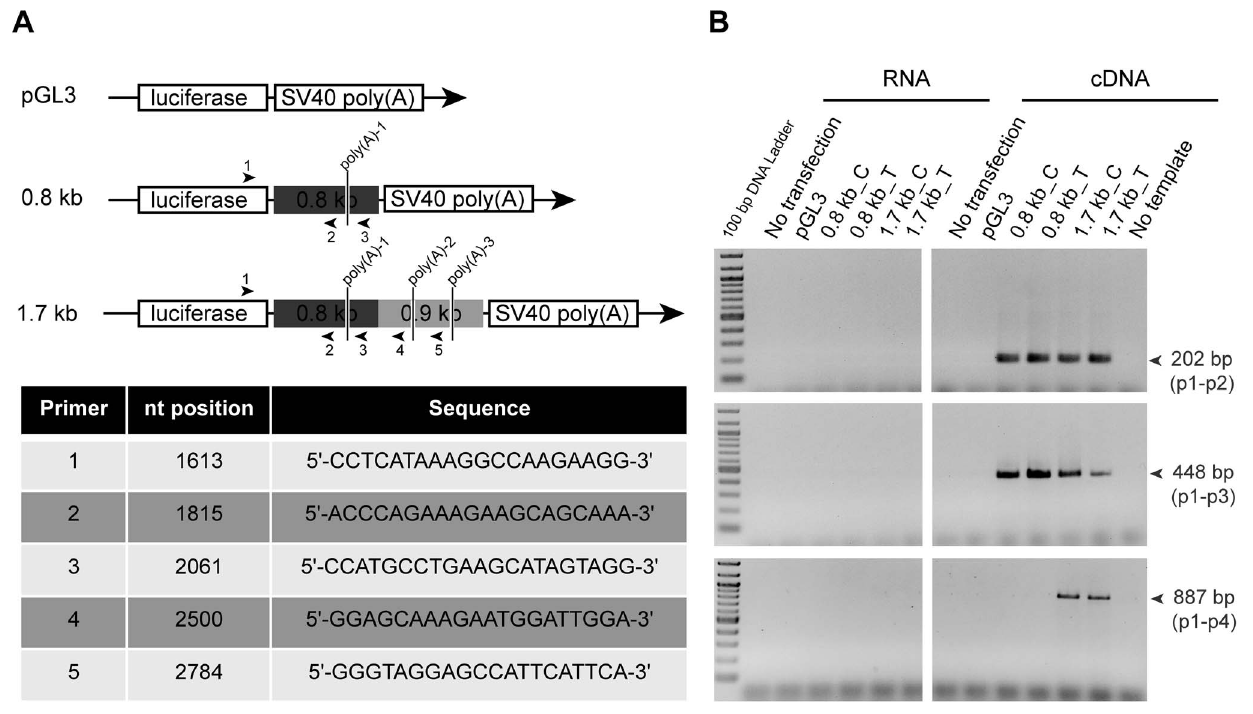
Figure 3. The length of transcripts generated is construct-dependent. (A) Schematic representation of the empty pGL3 vector and 0.8 kb and 1.7 kb constructs. Predicted poly(A) signals are indicated in each construct in between primers used. The numbers and little arrows indicate forward (above the construct) and reverse (below the construct) primers used. The table below shows the nucleotide position of each primer, relative to the transcription initiation site of luciferase gene, and its sequence. (B) PCR products using pairs of primers (1–2), (1–3), and (1–4) and RNA or cDNA templates obtained from N2A cells without transfection or either transfected with empty pGL3 vector or 0.8_C/T and 1.7_C/T kb constructs. RNA was used as template to control for bacterial DNA